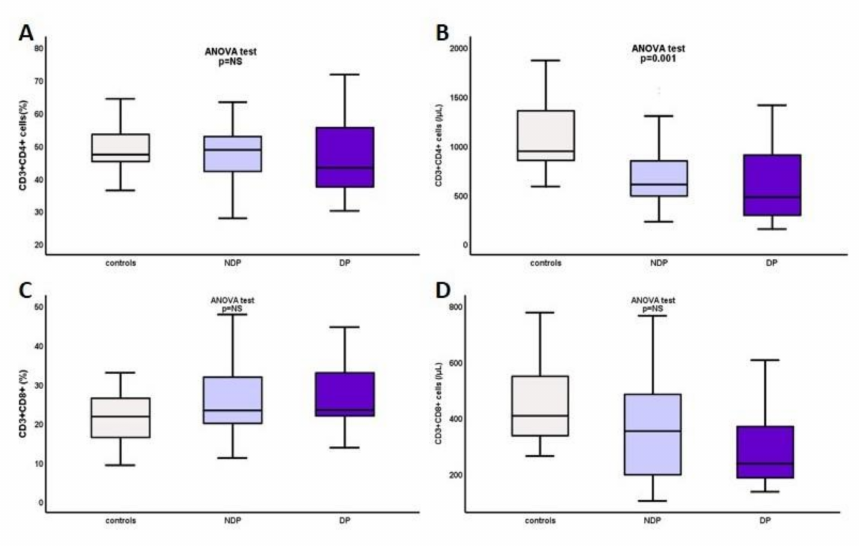
Figure 2. ( A , B ) CD3+CD4+ percentage and total count, and ( C , D ) CD3+CD8+ percentage and total count in DM, NDM, and